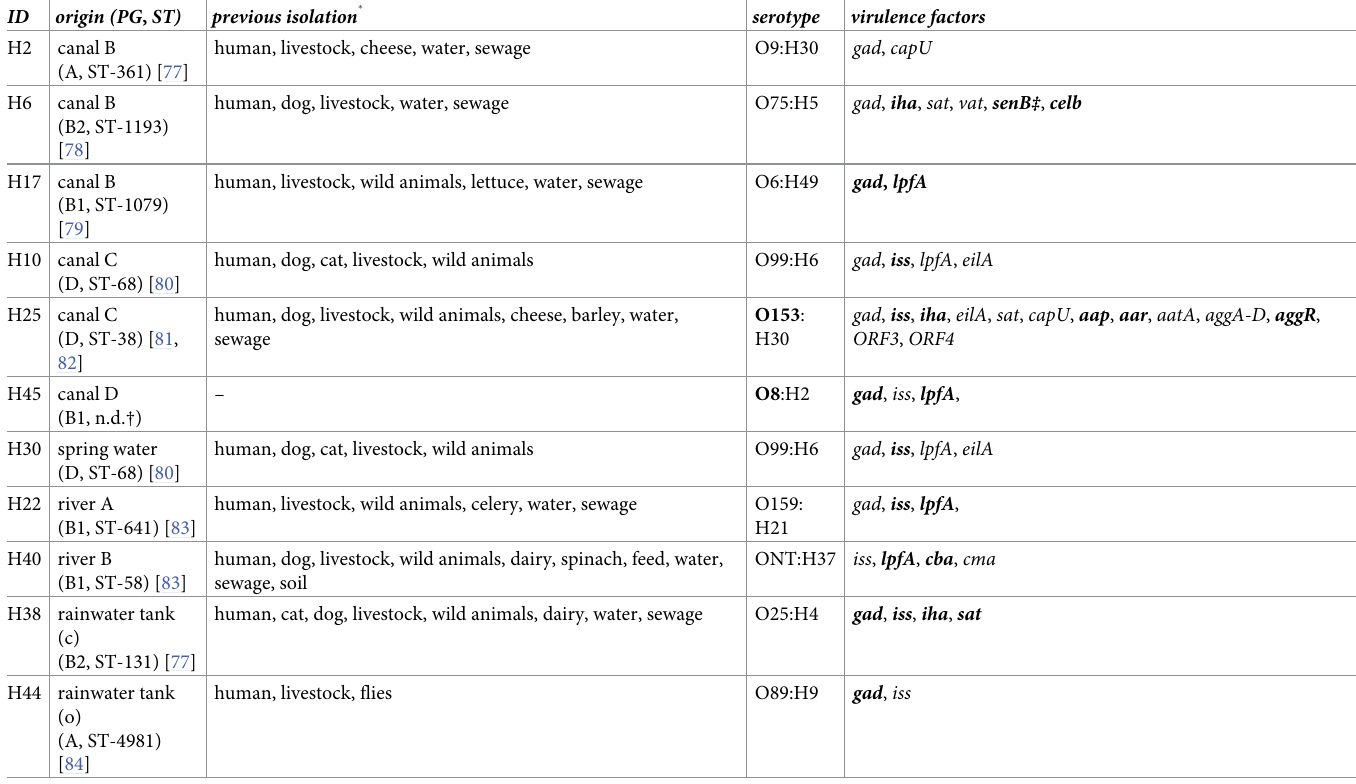
Table 2. Virulence factors detected in ESBL-producing E . coli from irritation water by whole-cell and plasmid DNA